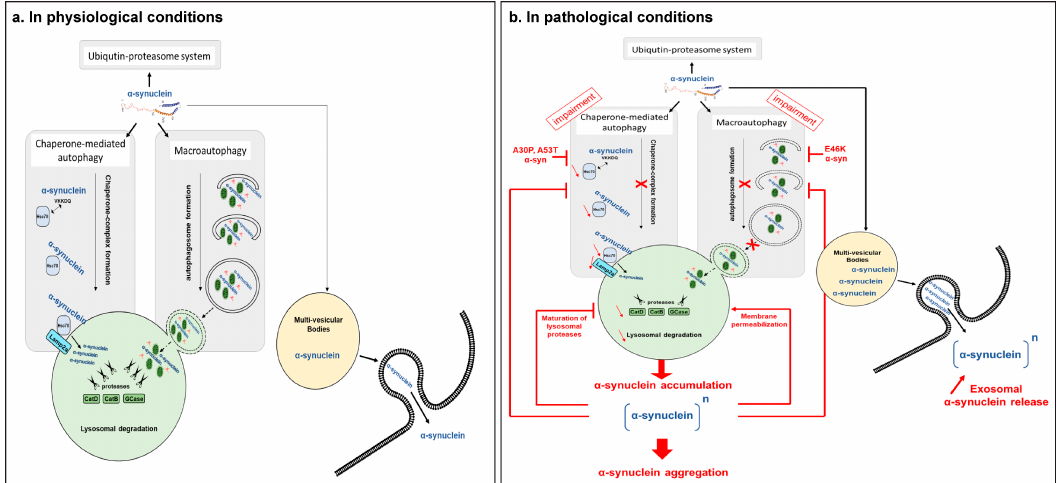
Figure 1. Dual loop between autophagy lysosomal pathway and α -synuclein. ( a ) In physiological conditions, autophagy machinery participates in α -synuclein degradation through both macroautophagy and chaperone-mediated autophagy. The intracellular α -synuclein levels are maintained at basal conditions and exosomal α -synuclein release is low. ( b ) In pathological conditions, autophagy impairment leads to decreased α -synuclein clearance. Intracellular α -synuclein accumulates in the cells and participates in the α -synuclein aggregative process. To compensate for this defect, the cell attempts to eliminate α -synuclein through the exosomal pathway, inducing increased released α -synuclein amounts and cell-to-cell propagation of the protein. Reciprocally, accumulated pathological α -synuclein induces cell toxicity mediated in part by autophagy impairment, diving the cell into an endless cycle of dyshomeostasis. Hsc70: cytosolic chaperone heat-shock cognate 70kDa protein; CatD: Cathepsin D; CatB: Cathepsin B; GCase: β -glucocerebrosidase.